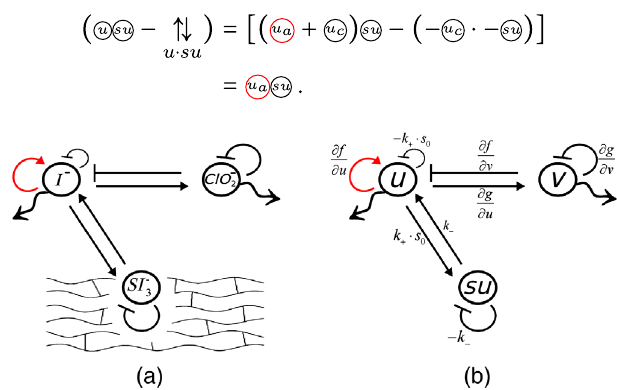
FIG. 11. (a) The CIMA reaction modeled by Lengyel and Epstein [15]. Iodine I − acts as the activator, chlorite ClO − 2 as the inhibitor, and the starch-iodine complex SI − 3 cannot diffuse because it is trapped by the medium. (b) The reaction-diffusion graph associated to the Lengyel-Epstein model of the CIMA